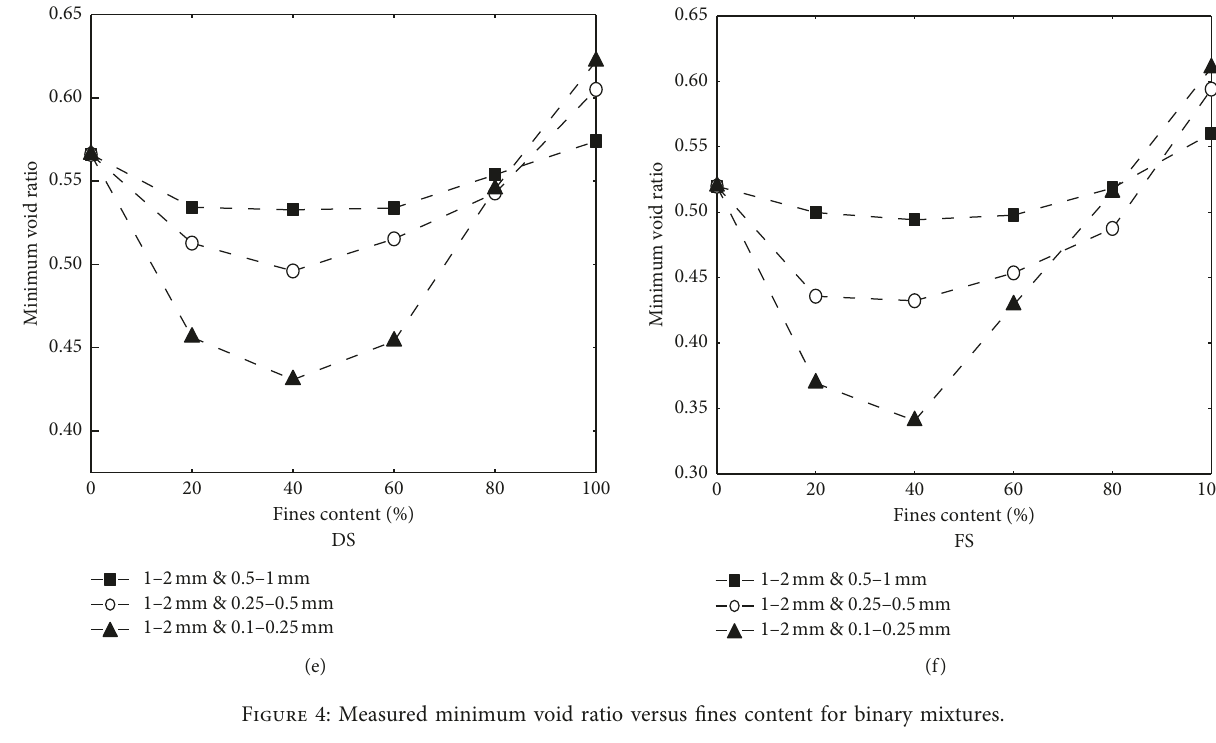
Figure 4: Measured minimum void ratio versus fines content for binary mixtures.